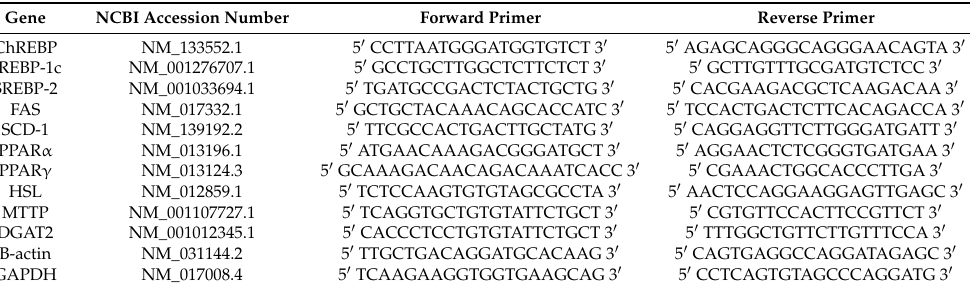
Table A1. List pf primers used for RT-qPCR